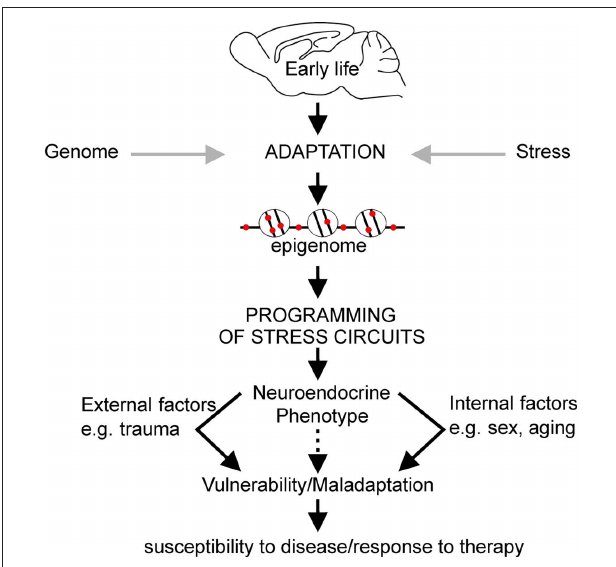
Figure 3 | early life experience can persistently alter expression levels of key genes through epigenetic marking which can underpin changes in behavior, neuroendocrine, and stress responsivity throughout later life. Collectively, this process is referred to as epigenetic programming. The nature of the environment throughout later life, in addition to the impact of biological processes associated with aging and genetic sex, may exacerbate the effects of programming established during early life resulting in increased vulnerability to mood